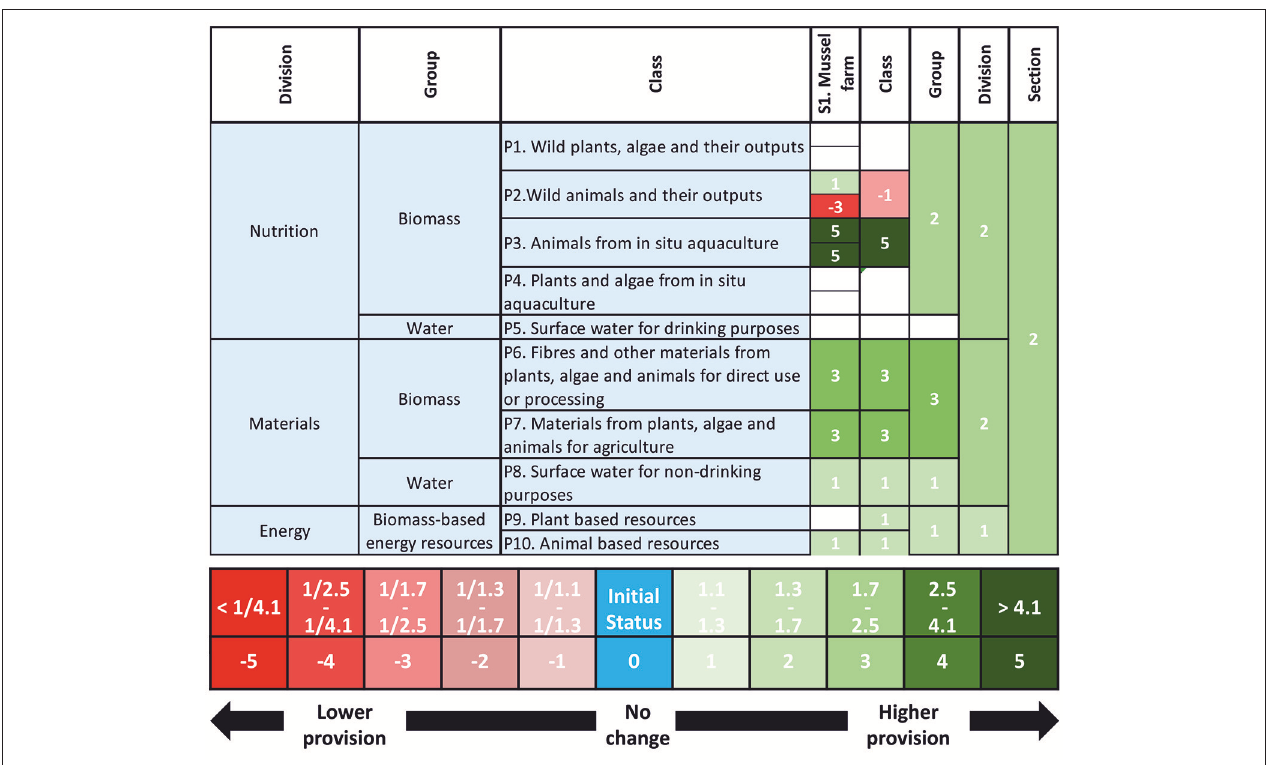
FIGURE 4 | Excerpt of the Ecosystem Service Assessment Tool (ESAT) showing the assessment of few provisioning ecosystem services. The numbers indicate the scores on indicator level and the automatic averaging process to obtain ES classes, groups, divisions, and sections. Below the relative scoring system used in the expert assessments. Scored are the changes resulting from the implementation of measures (scenarios), compared to the present